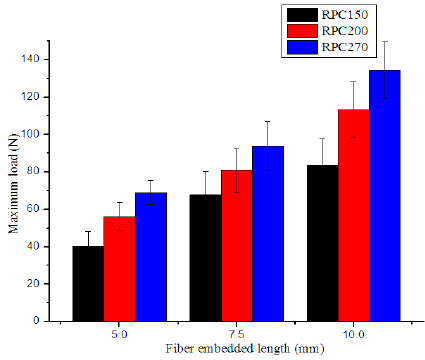
Figure 10. Effects of embedded fiber length on maximum load.